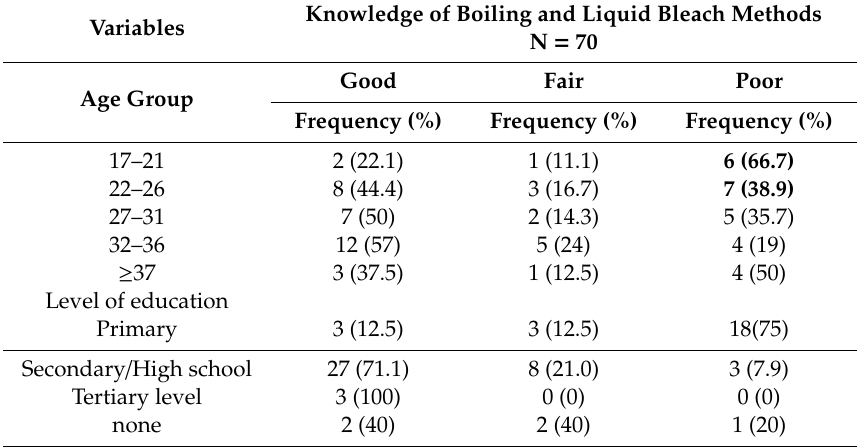
Table 3. Relationship between the knowledge of practised household water treatment methods and selected demographic profiles in Makwane Village prior to the implementation of HWTS.